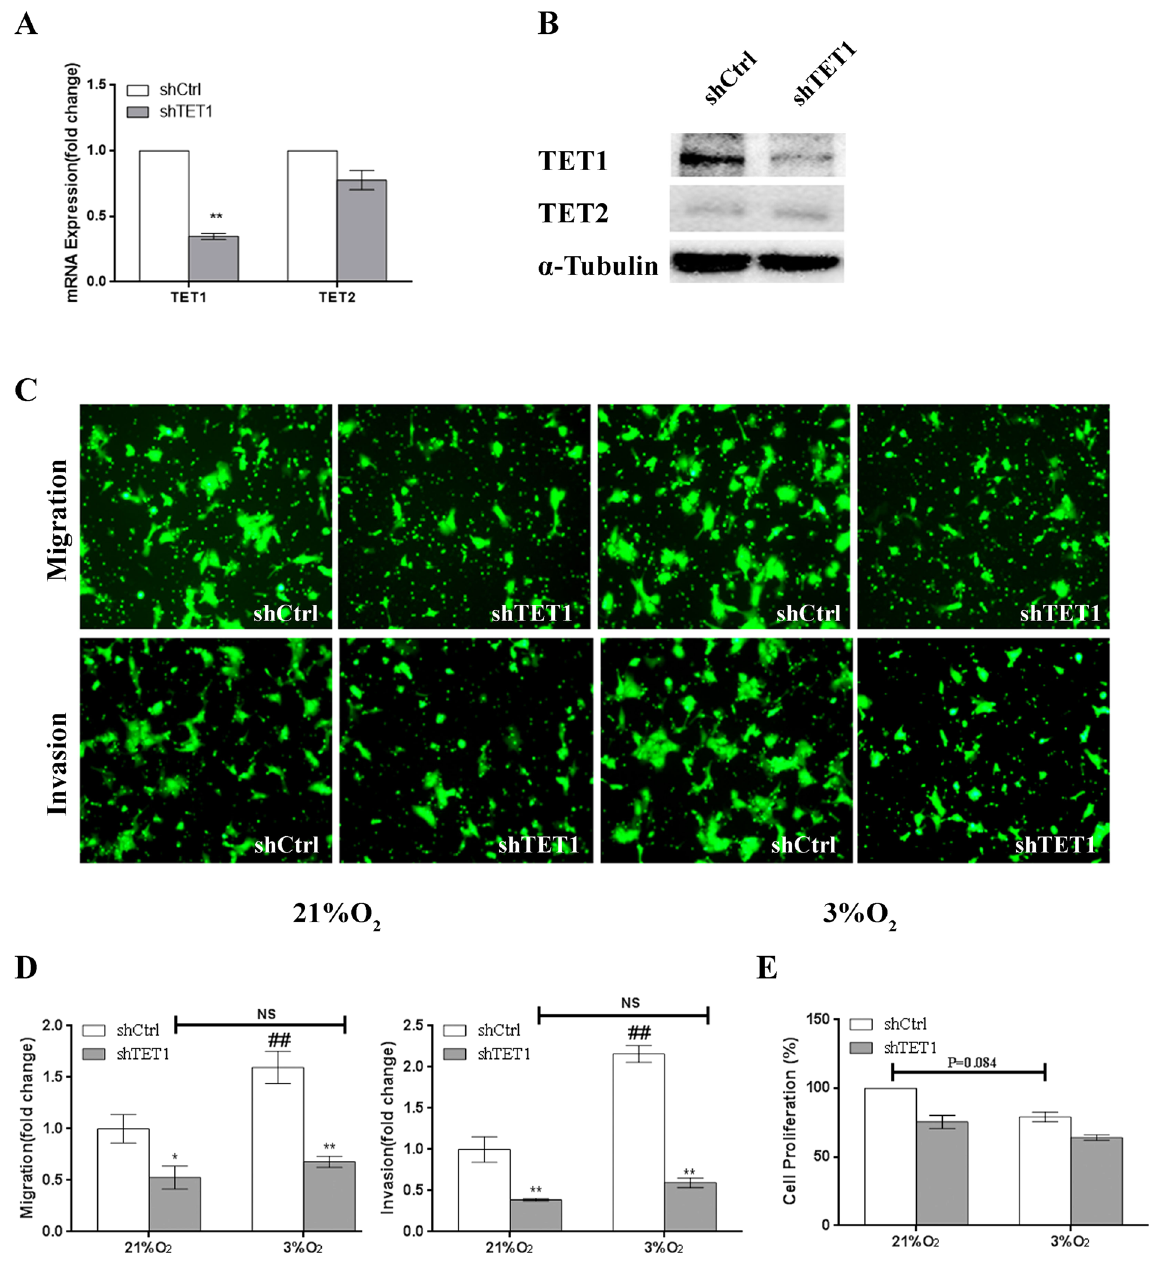
Figure-4. The migration and invasion capacities of JEG3 cells are more significantly suppressed by TET1 knockdown in cells exposed to 3% O 2 than in cells exposed to 21% O 2 . ( A , B ) Real-time q PCR and western blot analyses showing the specific knockdown of TET1 in JEG3 cells by shRNA. ( C ) The migration and invasion capacities of JEG3 cells transfected with scramble shRNA or TET1 shRNA and then exposed to 21% or 3% O 2 were assessed using the transwell assay. ( D ) The migrated or invaded cells were counted and the quantitative data are expressed as the fold change from the control of three independent experiments. ( * P < 0.05, ** P < 0.01, shCtrl vs. shTET1; ## P < 0.01 compared to shCtrl in 21% O 2 ; there was no significant difference between the shTET1 cells exposed to 3% and 21% O 2 , one-way ANOVA) ( E ) Proliferation capacity of JEG3 cells transfected with scramble shRNA or TET1 shRNA and then exposed 3% O 2 . (P = 0.0.84, between the shCtrl cells exposed to 3% and 21% O 2 , one-way